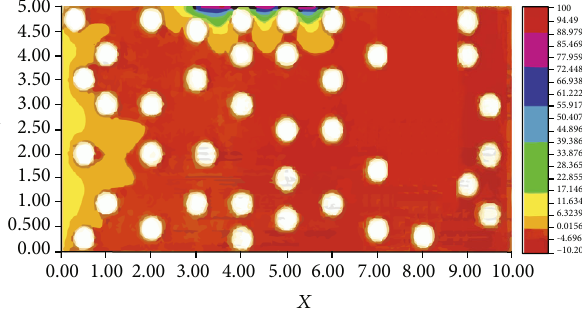
Figure 15: Concentration, D = 0 : 5 , C